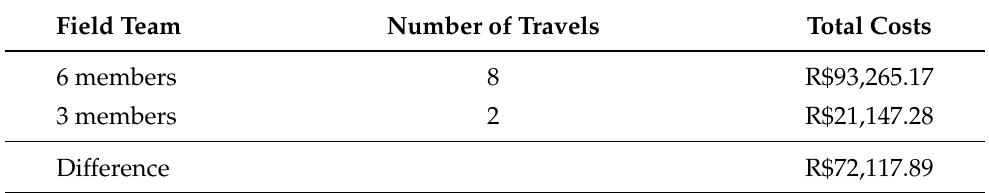
Table 2. Comparison of costs between E+BOX project and COELCE MG